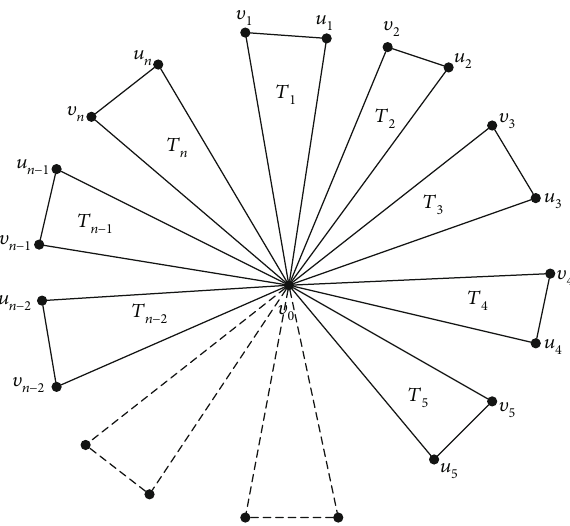
Figure 17: The friendship graph Fr